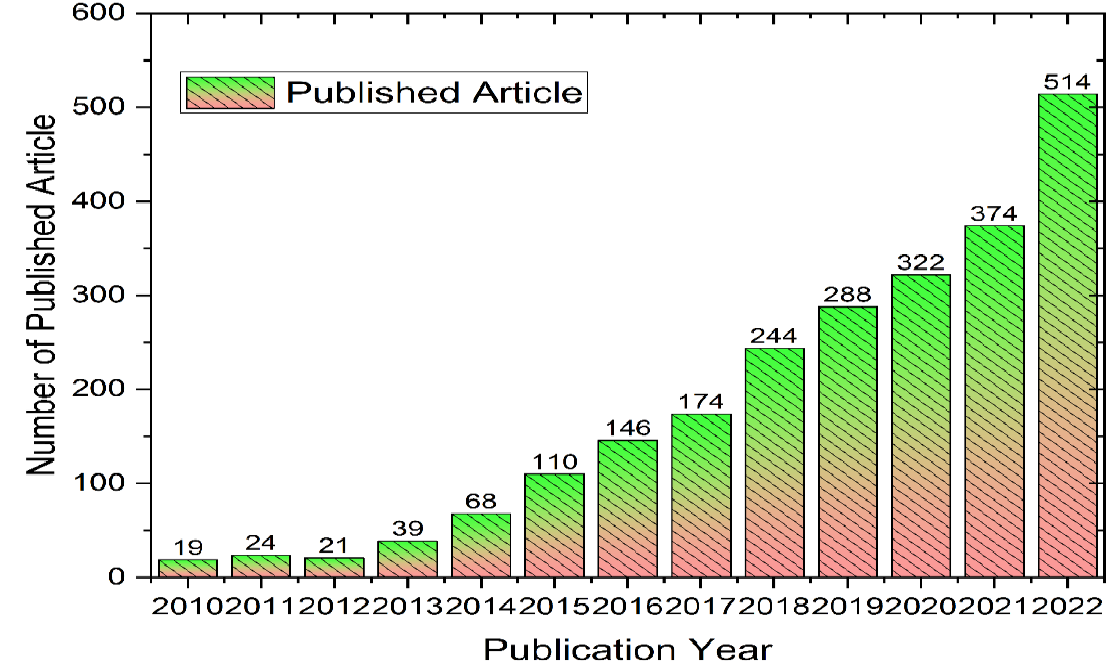
Figure 1. Number of publications on “metal oxide nanosheet s ” from 2010– 2022.